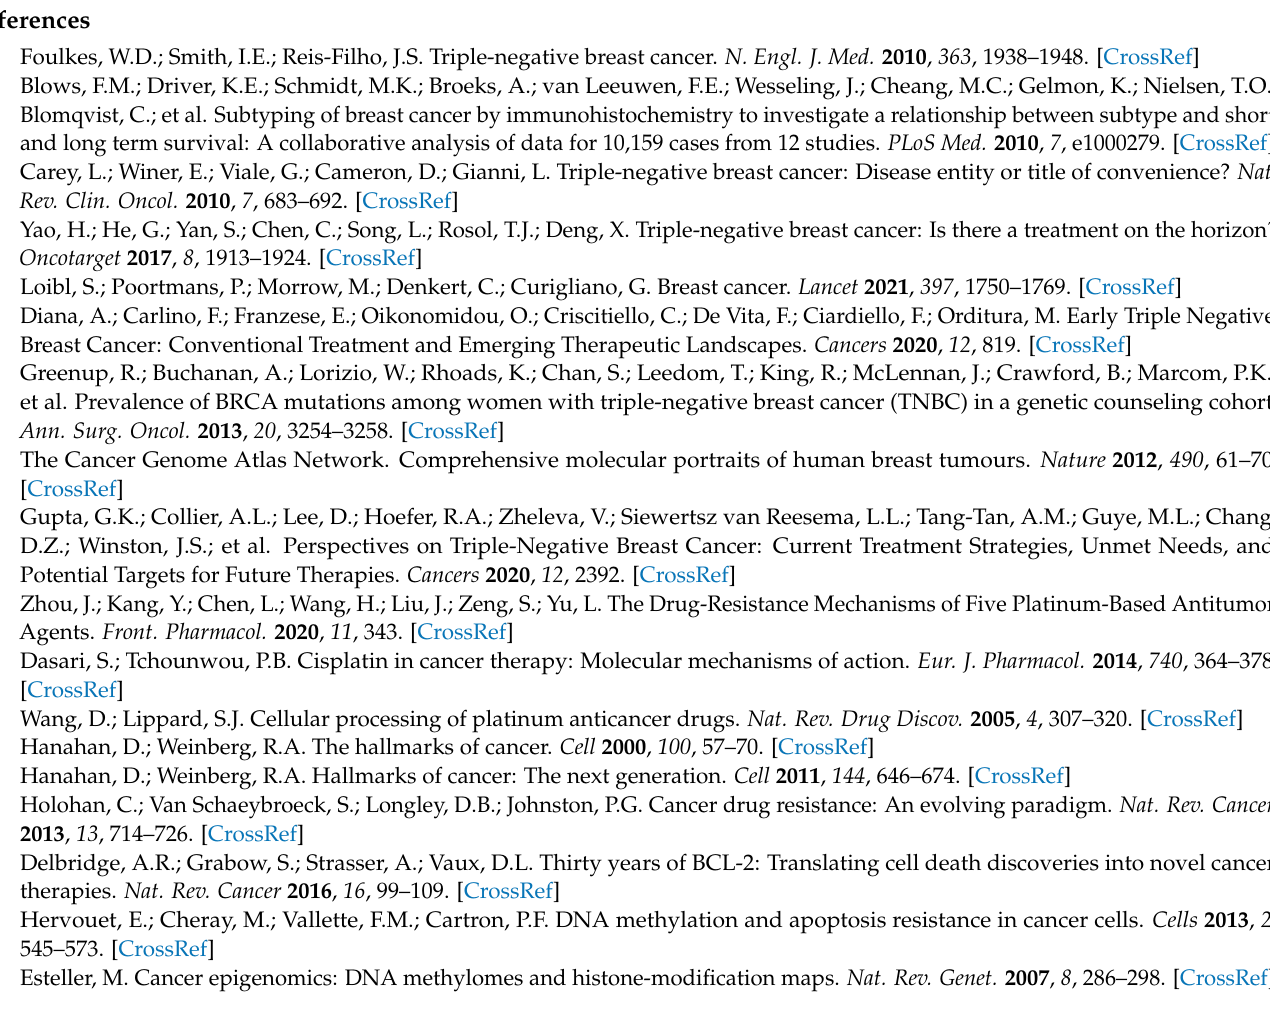
immunoblot from Figure 3, Figure S3: Raw data of immunoblot from Figure 4, Figure S4: Raw data of immunoblot from Figure 5, Figure S5: Raw data of immunoblot from Figure 6, Figure S6: KLF4